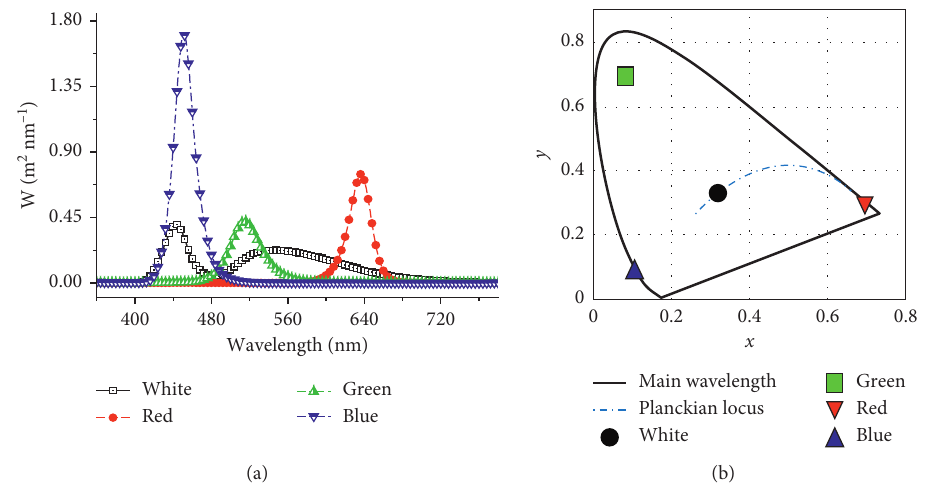
Figure 1: Spectral distribution (a) and the Herm Holtz (b) profiles of LED